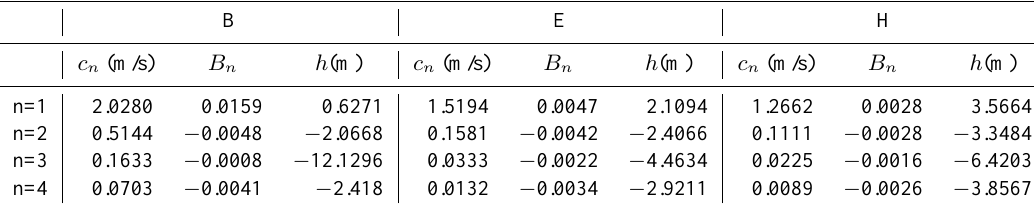
Table 2. Characteristics of the first four modes (denoted by index n ) for the three transects analysed ( B , E and H ); c n is the velocity of propagation of the mode, B n is the ratio of the sea level change across the shelf to the thermocline displacement at the shelf edge, and h is the thermocline displacement at the shelf edge B E H c n (m/s) B n c n